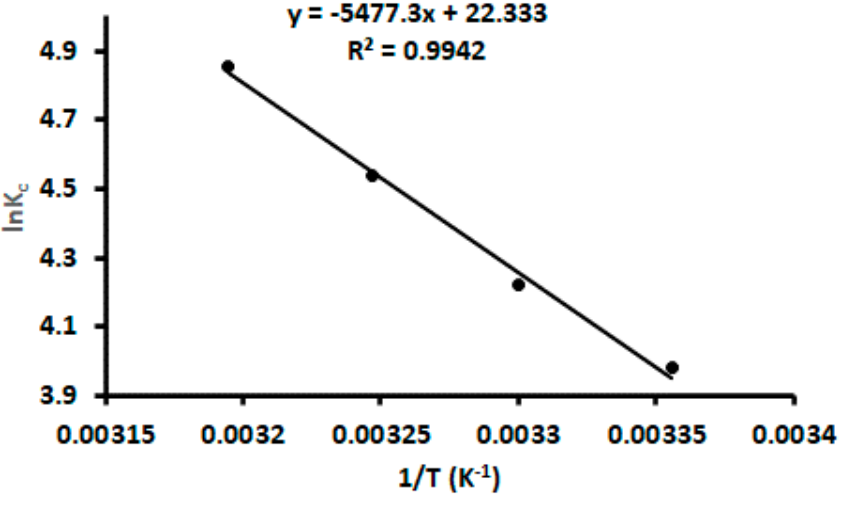
Figure 7. Van’t Ho ff plot calculation of for thermodynamic parameters. Figure 7. Van’t Hoff plot calculation of for thermodynamic parameters.